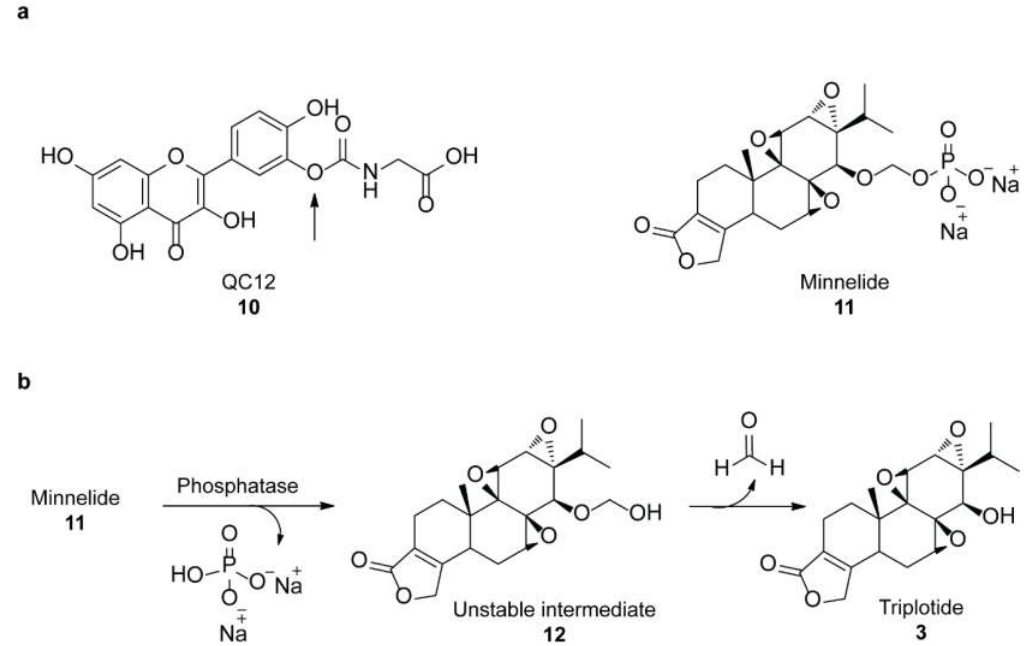
Figure 4. ( a ) Chemical structures of QC12 (the structure is hydrolyzed in-vivo at the arrowed oxygen to release quercetin and glycine) and Minnelide; ( b ) Phosphatases cleave the phosphate group from minnelide to yield an unstable O-hydroxymethyl intermediate ( 12 ) which degrades into formaldehyde and anticancer compound triptolide.